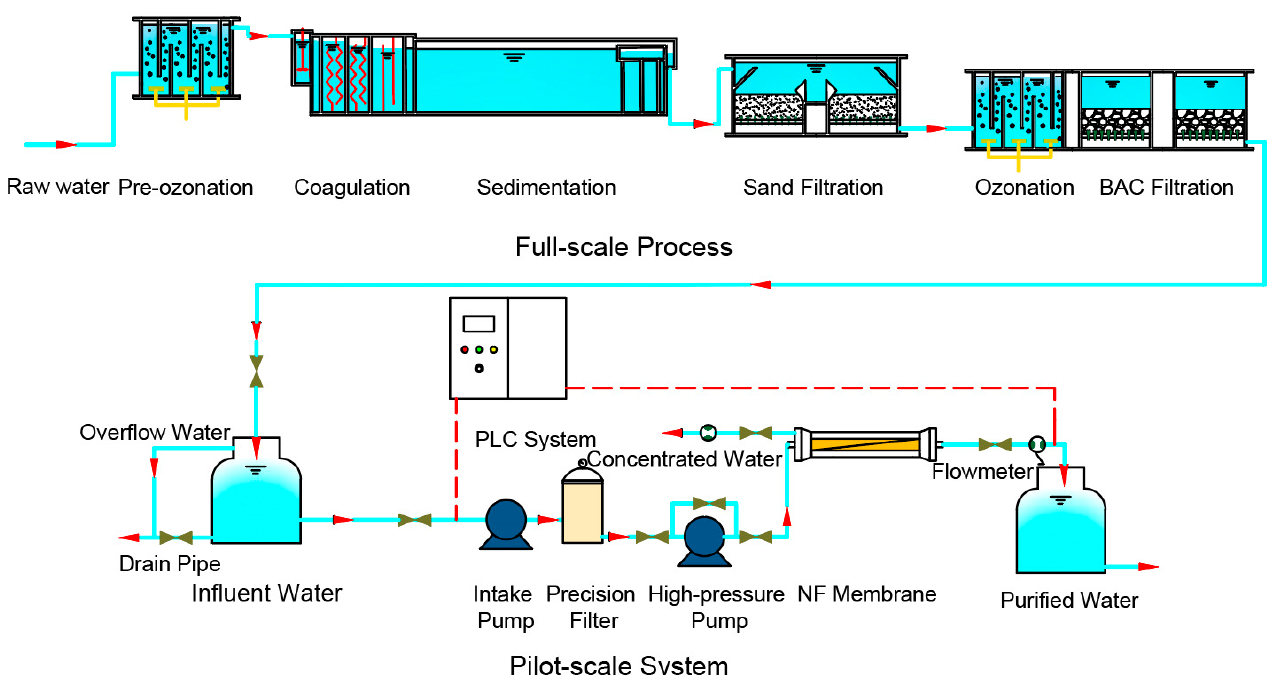
Figure 1. Scheme of the full-scale treatment processes plus the pilot-scale NF system at the drinking water treatment plant (DWTP) in this study. Raw water of the DWTP comes from the East Taihu Lake, which is one of the primary drinking water sources in Suzhou City, Jiangsu Province, China. The pilot-scale NF system was operated during August 2020–December 2021, and the samples (from both the full-scale and pilot-scale processes) were collected regularly during this period.